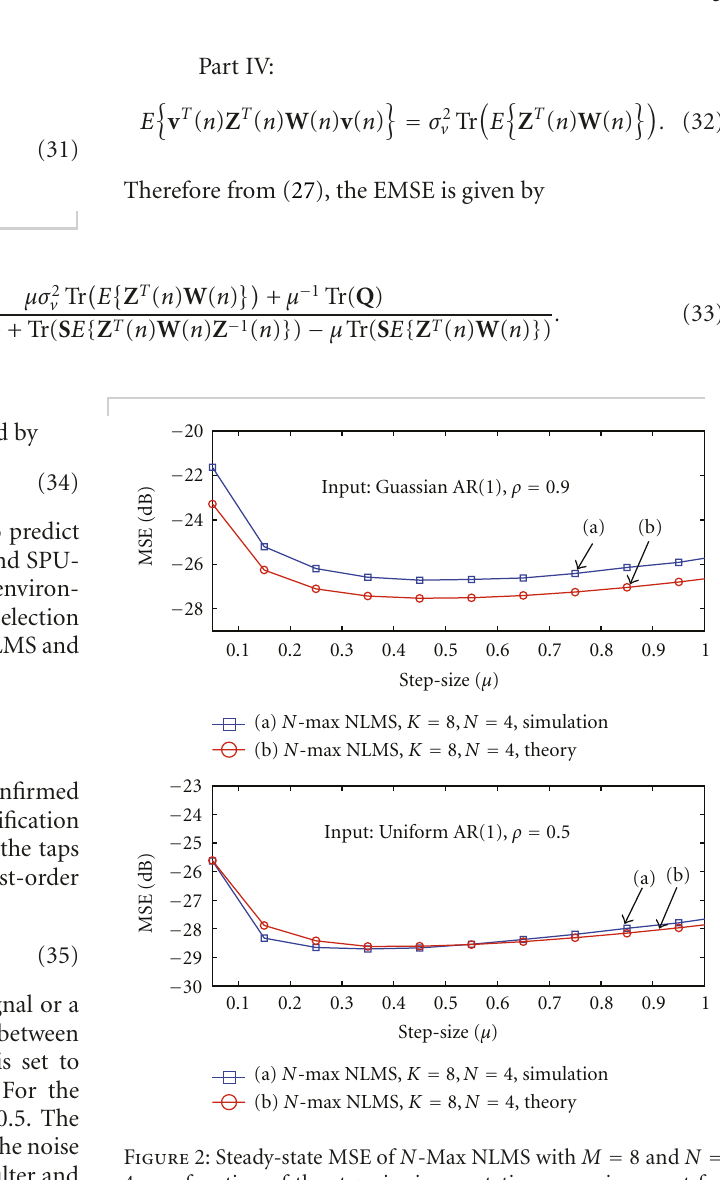
5, we presented the results for N = 6, and N = 7